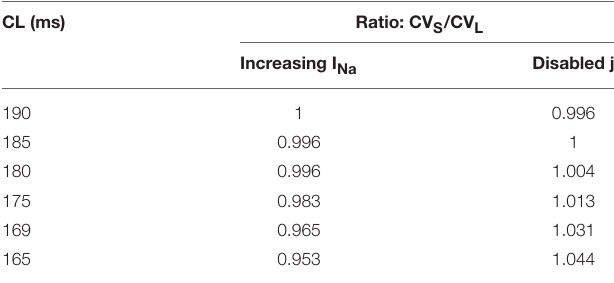
TABLE 2 | Ratio of CVs for short AP and long AP during alternans (CL ≤ 190ms).